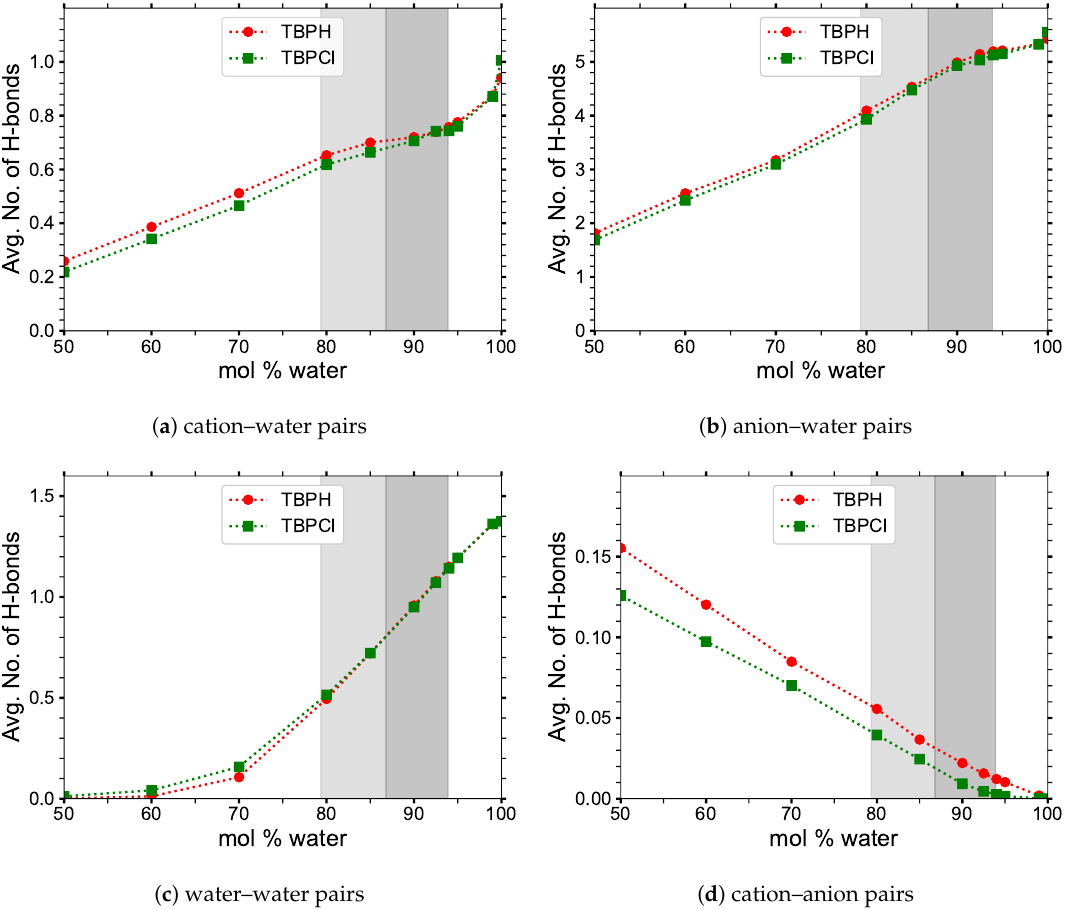
Figure 12. Average number of hydrogen bonds at 300K: ( a ) cation–water pairs; ( b ) anion–water pairs; ( c ) water–water pairs; ( d ) cation–anion pairs. The first part of the labeling represents the per molecule basis (i.e., x-y represents the average number of hydrogen bonds between x and y per molecule of